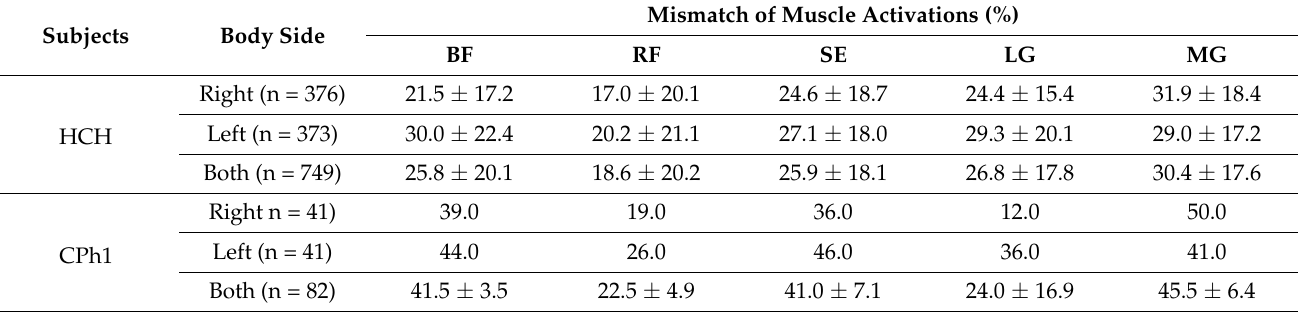
Table A1. Results of the SPM